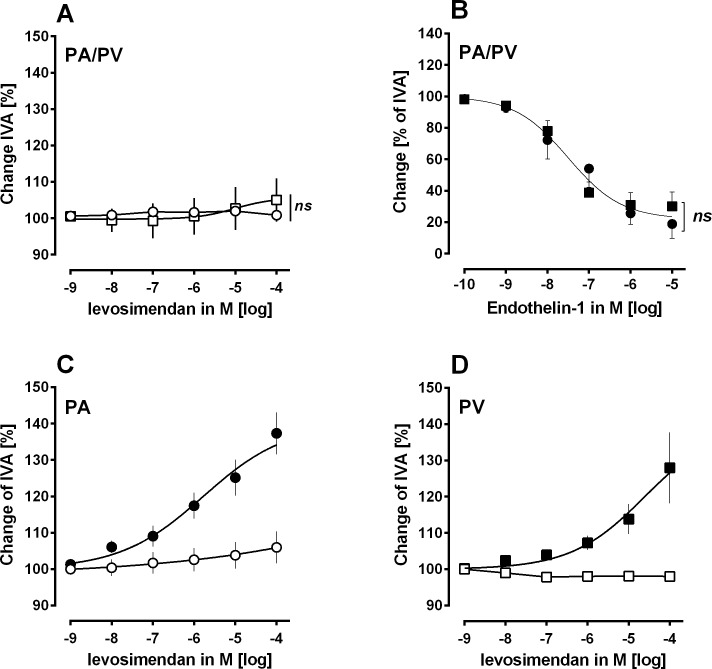
Effect of ET-1 and levosimendan in human PCLS.A) Concentration-response curve of levosimendan in PAs and PVs: ○ naïve PAs (n = 5); □ naïve PVs (n = 6). B) Concentration-response curve of ET-1: ● naïve PAs (n = 7); ■ naïve PVs (n = 6). C) Concentration-response curve of levosimendan in ET-1 pre-constricted PAs: ○ 100 nM ET-1 (n = 6); ● 100 nM ET-1 / levosimendan (n = 6). D) Concentration-response curve of levosimendan in ET-1 pre-constricted PVs: □ 50 nM ET-1 (n = 7); ■ 50 nM ET-1 / levosimendan (n = 8). B: Statistics was performed by the comparison of EC50 values. P<0.05 are considered as significant.